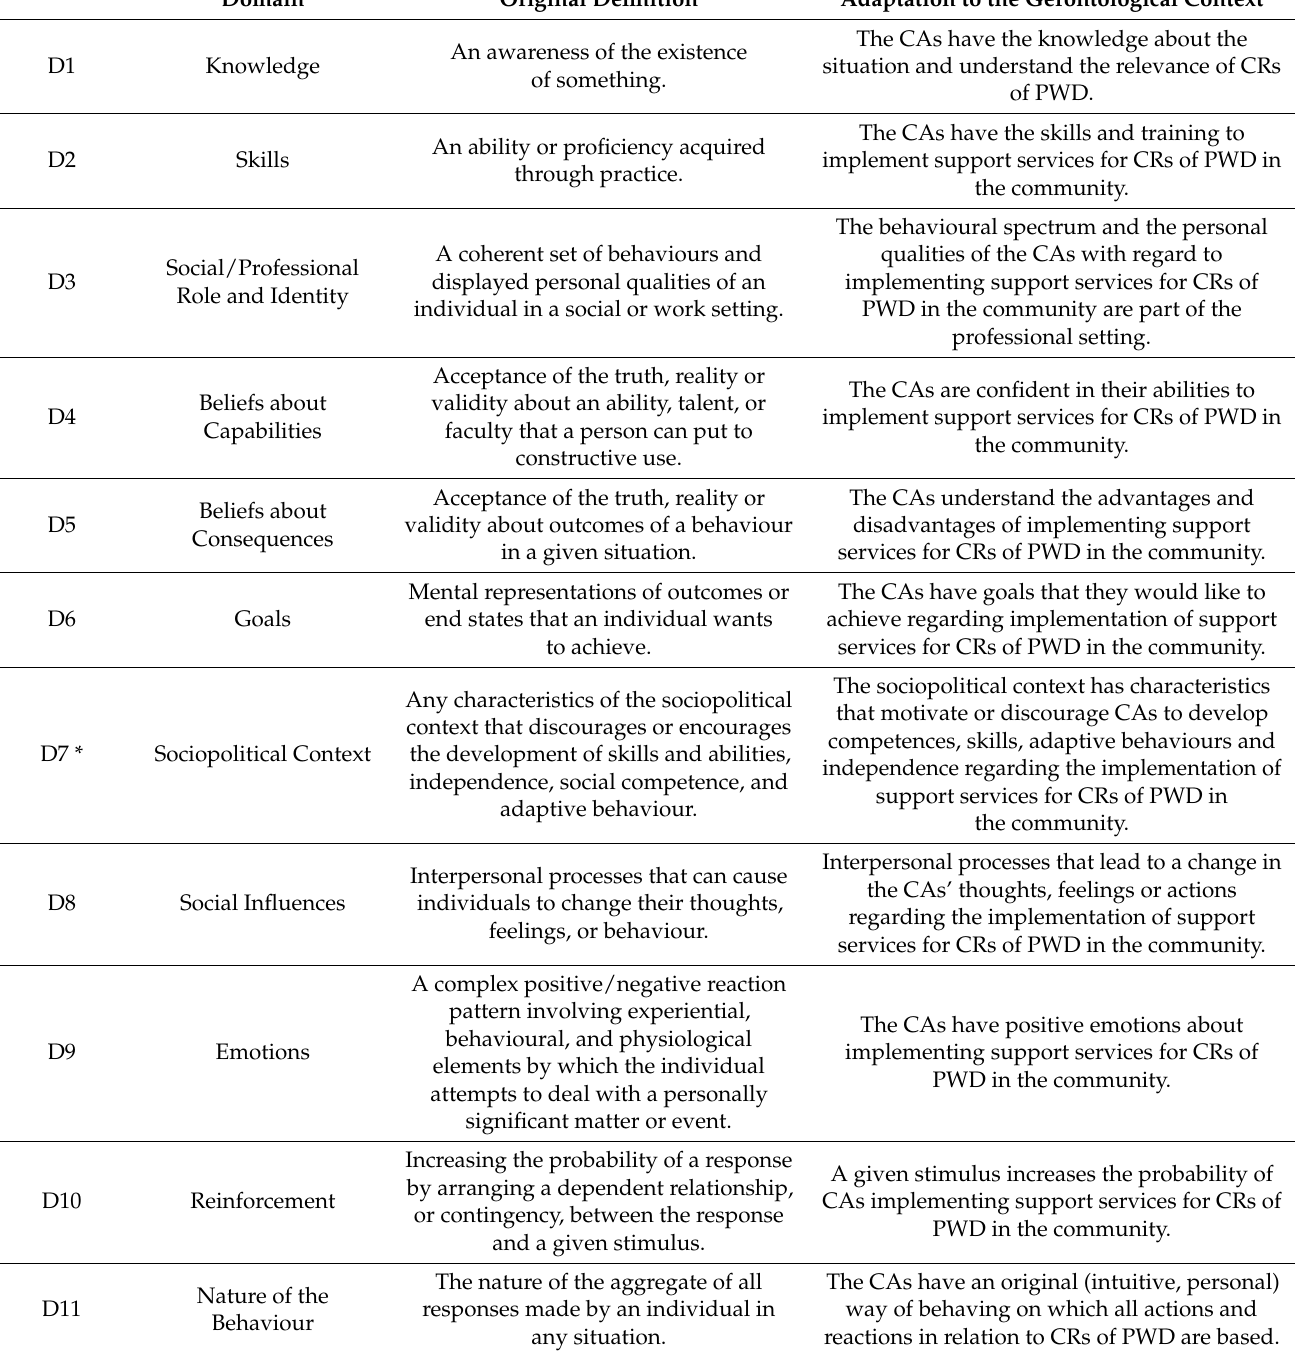
Table 1. Definition of the domains and the adaptation to the gerontological